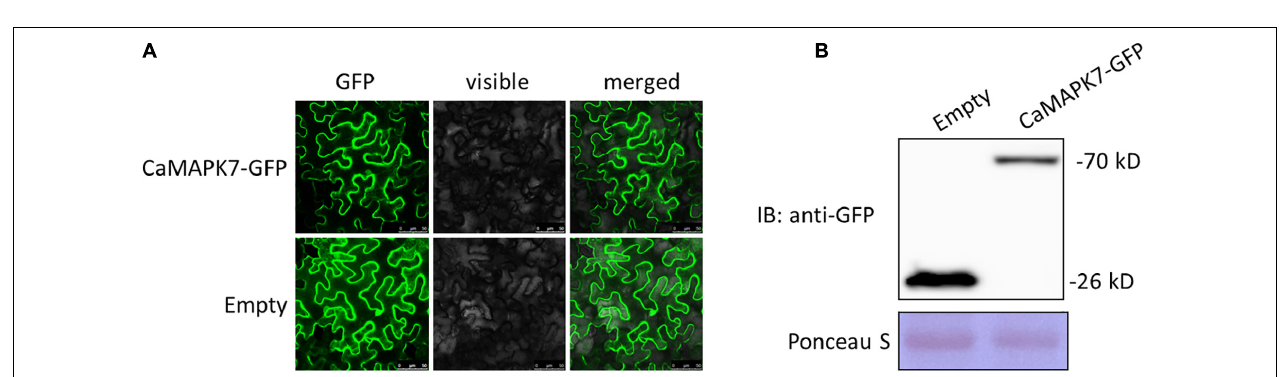
FIGURE 2 | Relative CaMAPK7 transcript levels in pepper plants in response to Ralstonia solanacearum infection and exogenously applied phytohormone treatments. (A–F) Relative CaMAPK7 transcript levels in pepper leaves at various time periods after treatment with 100 µ M ABA (A) , 100 µ M MeJA (B) , 10 µ M brassinolide (C) , 1 mM salicylic acid SA (D) , 100 µ M ethephon (E) , and R. solanacearum (F) . (A–F) CaMAPK7 transcript levels in pepper plants after treatment with R. solanacearum or hormones were compared with those in mock-treated control plants (normalized to a relative expression level of “1”). Asterisks indicate significant differences from three independent experiments based on the LSD test (* p < 0.01; ** p < 0.05).